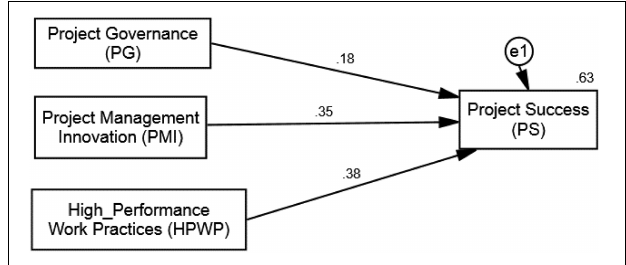
FIGURE 3 | Structural model 1 (direct paths without moderators).